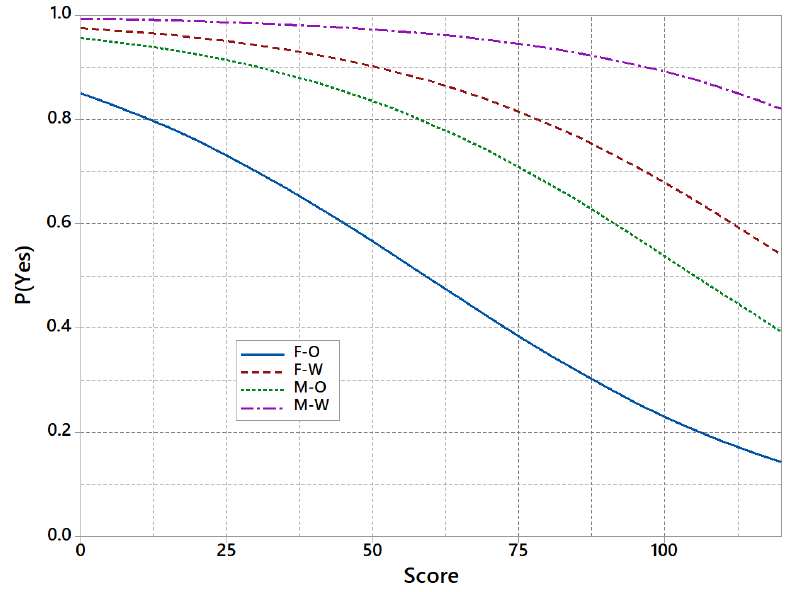
Figure 8. Biased model for P(Yes) vs Score by